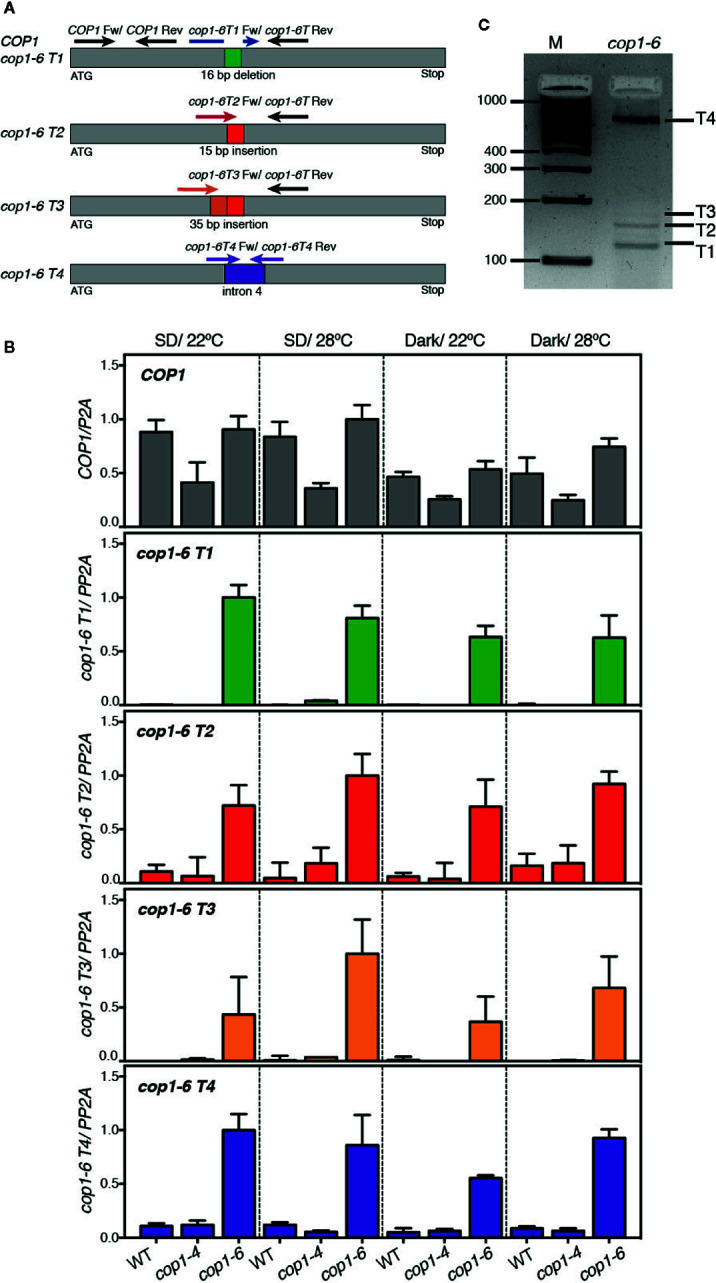
Analysis of expression levels of the cop1-6 T1-T4 transcripts. (A) Diagram showing the positions of primers used for quantitative RT-PCR analysis of cop1-6 T1-T4 and COP1. (B)
cop1-6 T1-T4 transcripts were detected in the cop1-6 mutant but not in the Col-0 and cop1-4 backgrounds. Total RNA was extracted from 5-day-old seedlings. PP2A was used to normalize gene expression levels. Relative levels are the relative quantification (RQ) mean of four technical replicates. Error bars indicate ± RQ maximum and minimum. (C) PCR products amplified from the cop1-6 cDNA using primers to 5’ and 3’-regions near the point mutation. PCR products were separated on a 3% agarose gel. M indicates the size of the molecular marker in base pairs.